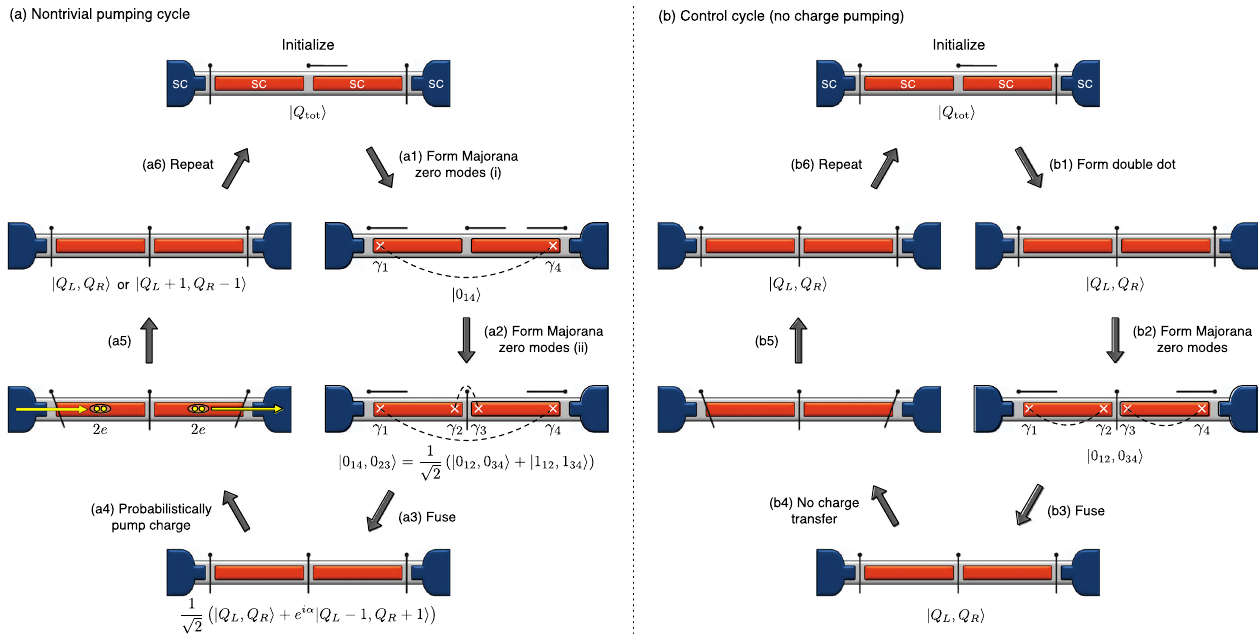
FIG. 7. (a) Nontrivial cycle that selectively pumps charge 2 e whenever Ising anyons fuse into the ψ channel, yielding a quantized zero- bias dc current [Eq. (22)] passing between the outer grounded superconductors. The sequence initially follows the left path from Fig. 6. Once the anyons nontrivially fuse into a superposition of I and ψ channels (bottom configuration), the cycle probabilistically pumps charge by pursuing the manipulations sketched in Fig. 8 and described in the text. Opening the middle valve then restores the islands to their original state, whereupon the process repeats. (b) Control cycle that initially follows the right path from Fig. 6 but is otherwise identical to (a). This alternate sequence blocks the ψ fusion channel and hence eliminates the current. The two cycles sketched here reveal the nontrivial Ising-anyon fusion rules via a macroscopic